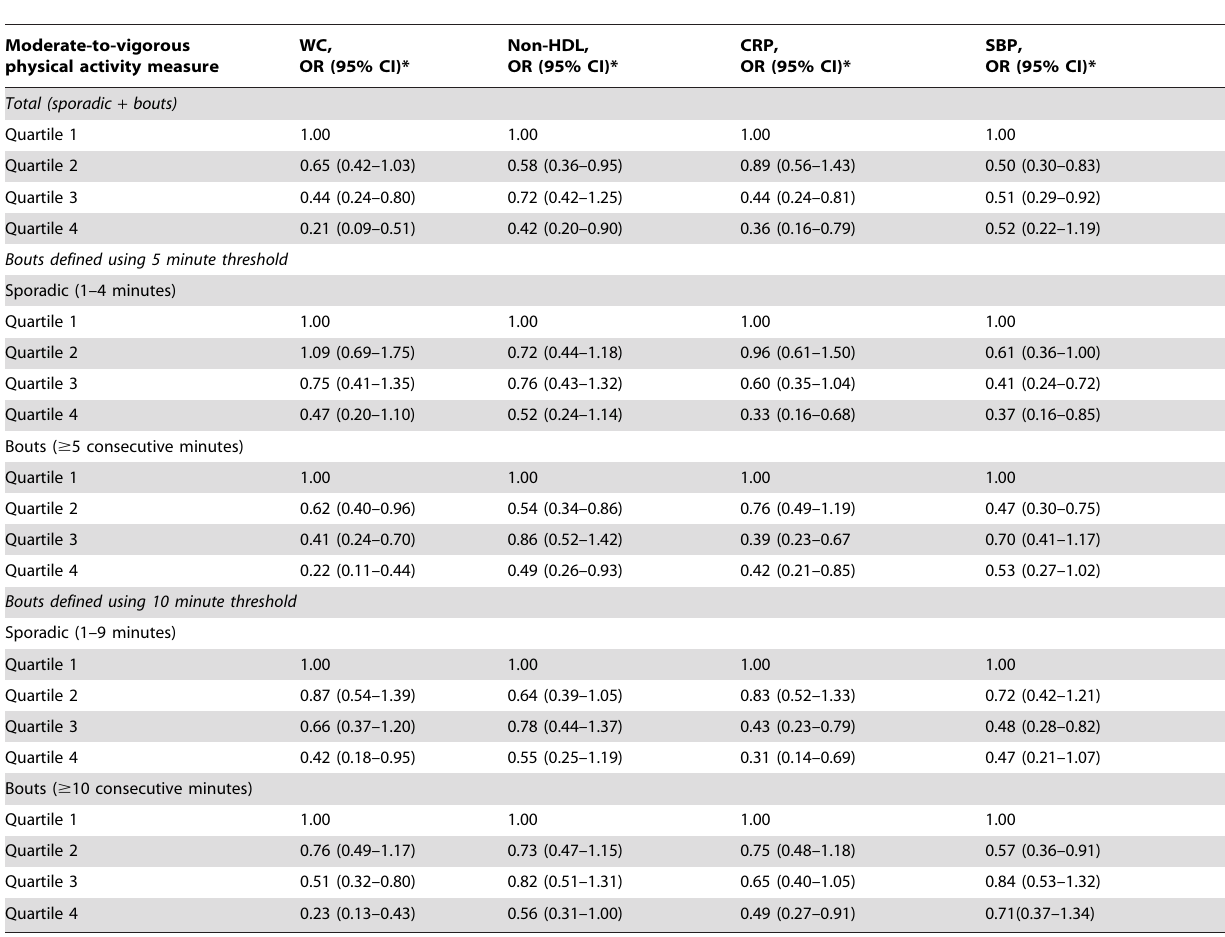
Table 4. Relations between moderate-to-vigorous physical activity measures and elevated levels of the individual cardiometabolic risk factors